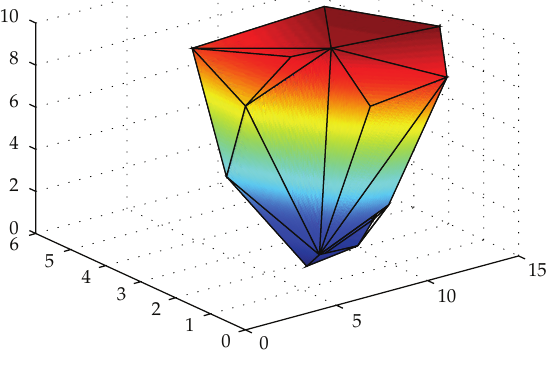
Figure 5: Convex hull, VRS.